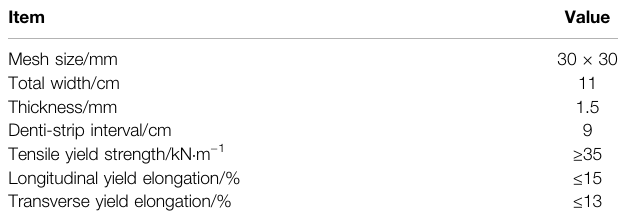
TABLE 1 | Technical indicators of the biaxial stretching plastic geogrid.